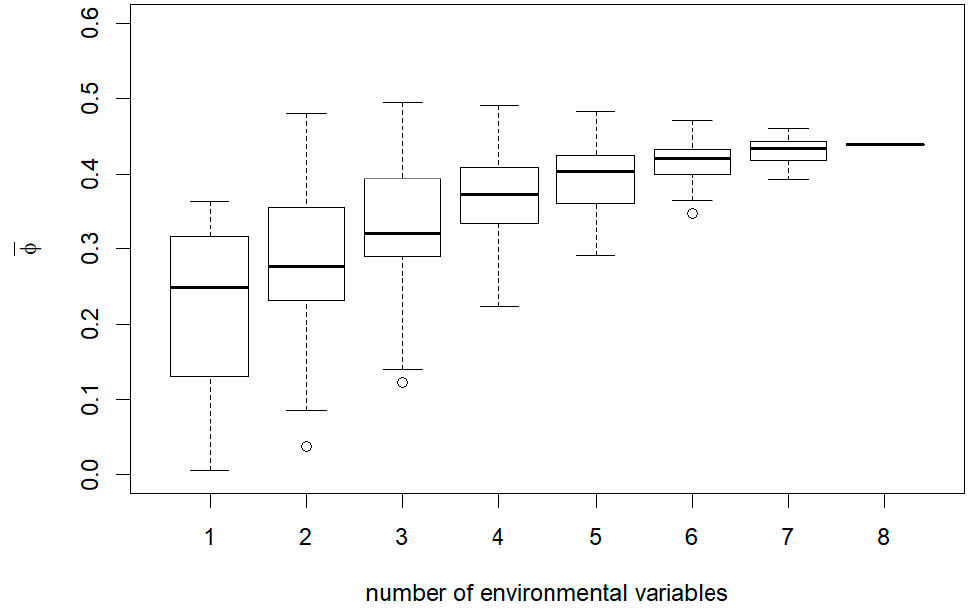
Figure A3. Box plot of mean phi coefficients ( φ ) of the FDMs generated by GBC as affected by the number of explanatory variables. Box plot shows median plus upper and lower quartiles for φ of FDMs with a given number of explanatory variables. Minimum and maximum values are indicated by the upper and lower whiskers (1.5 × interquartile range). Circles are outliers.